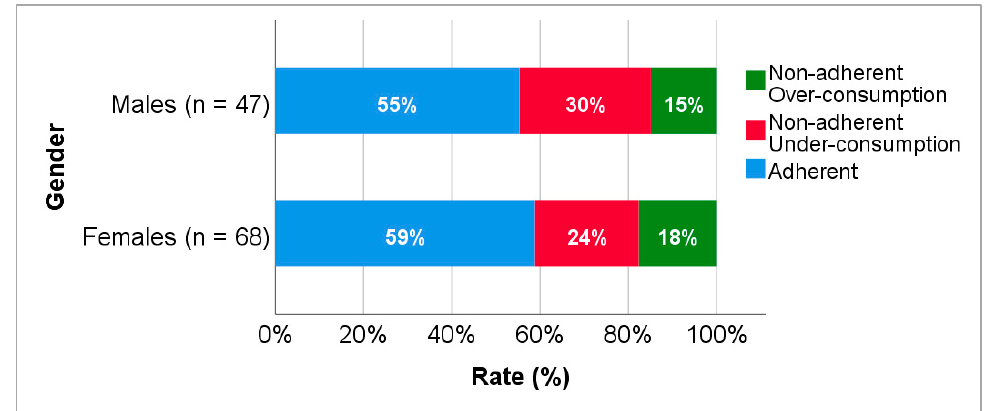
Figure 2. Adherence to levetiracetam treatment according to gender.